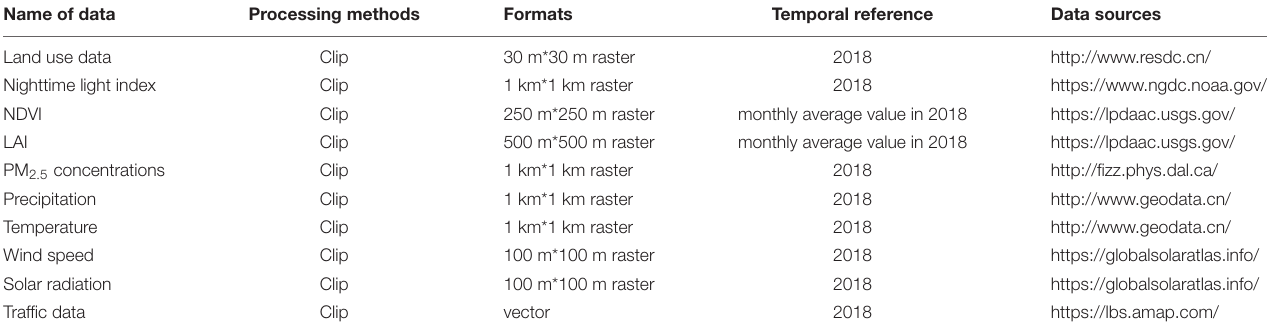
TABLE 1 | General status of data for study.